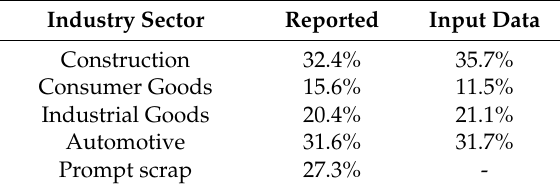
Table 2. Relative contribution of scrap from different industry sectors to obsolete steel scrap collection for the year 2014. Results of the scrap survey [25] and adjusted values used as input data in the